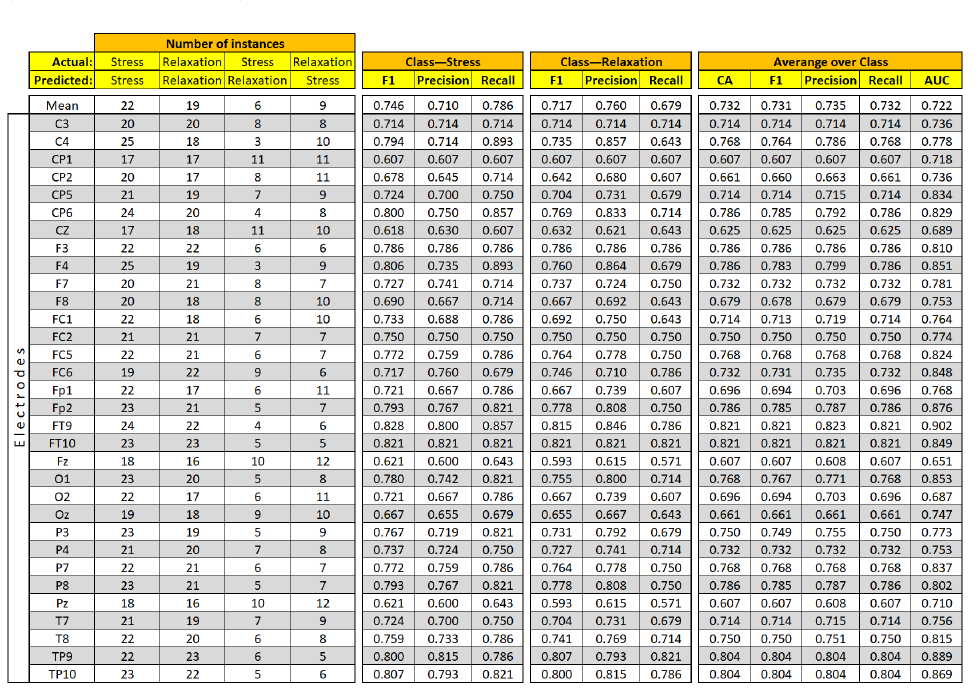
Figure 13. Classification results, mean value based on analysis of all electrodes, and values based on analysis of individual electrodes. Legend: CA—accuracy classification score; F1—f-score; AUC—area under the ROC